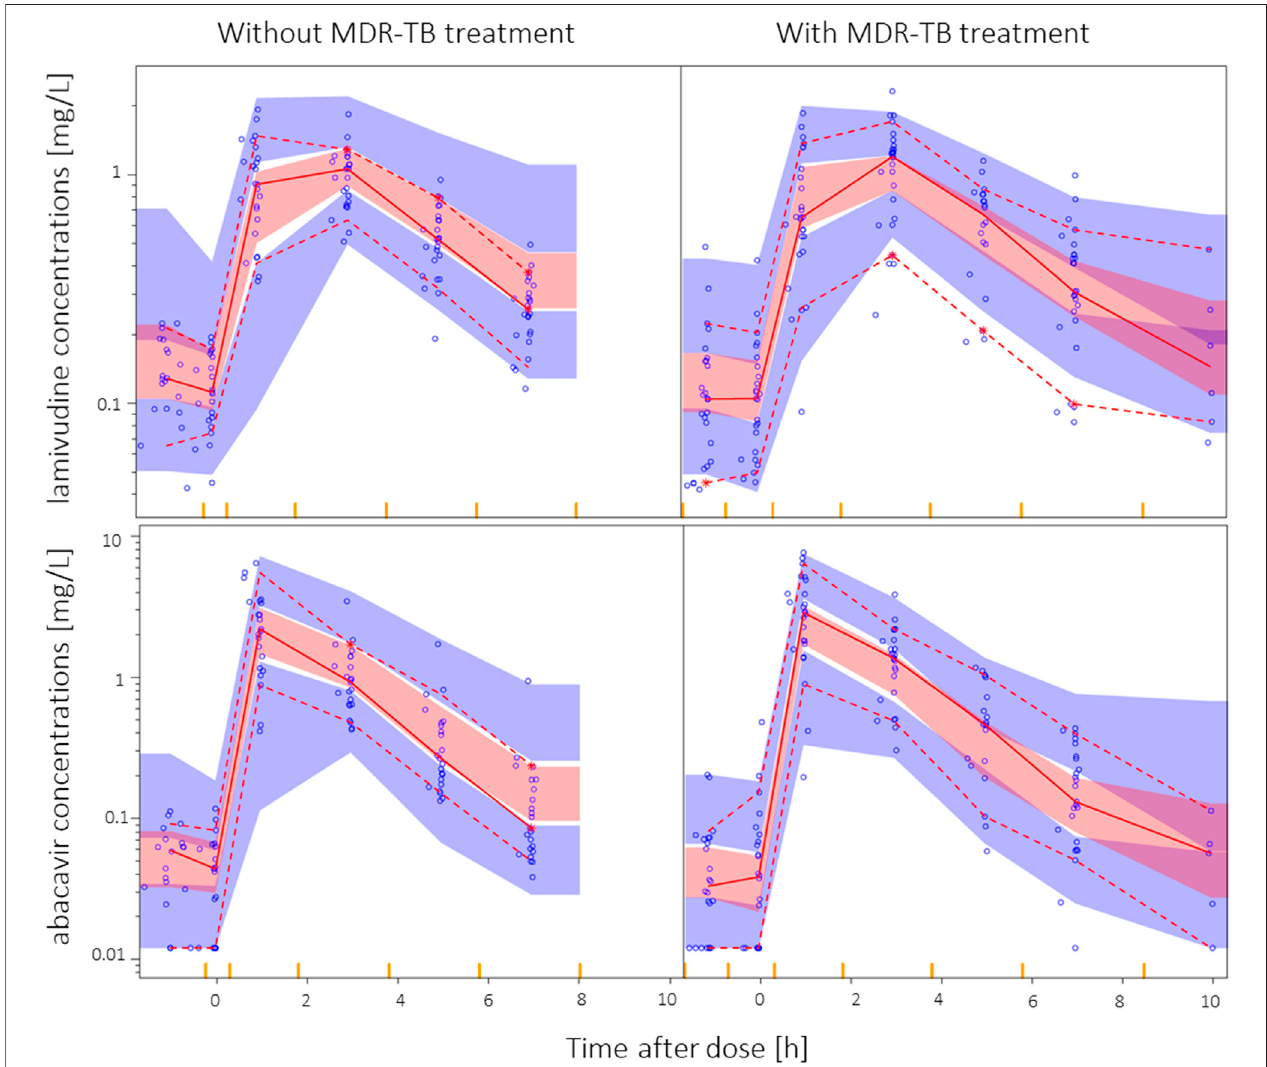
FIGURE 1 | Visual predictive check for lamivudine and abacavir in HIV-positive children strati fi ed by MDR-TB vs controls, using 1,000 simulations. The solid and dashed lines represent the fi fth, 50th, and 95th percentiles of the observed data, while the shaded areas (pink and blue) are the model-predicted 95% con fi dence intervals for the same percentiles. Observed data are displayed as blue circles. Two children on once-daily dosing, sampled at later time points, were removed for the visual predictive check for display purposes.